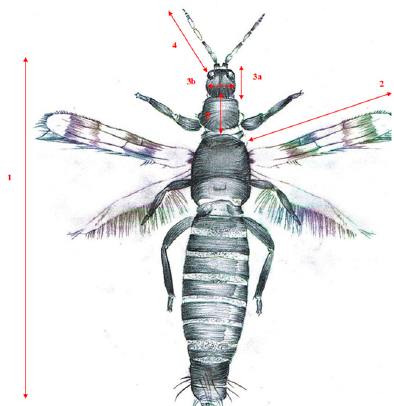
Figure 2. Measurements of the body parts of Aeolothrips intermedius. 1—body length, 2—forewing length, 3a—head length, 3b—head width, 4—antennae length, 5—pronotum